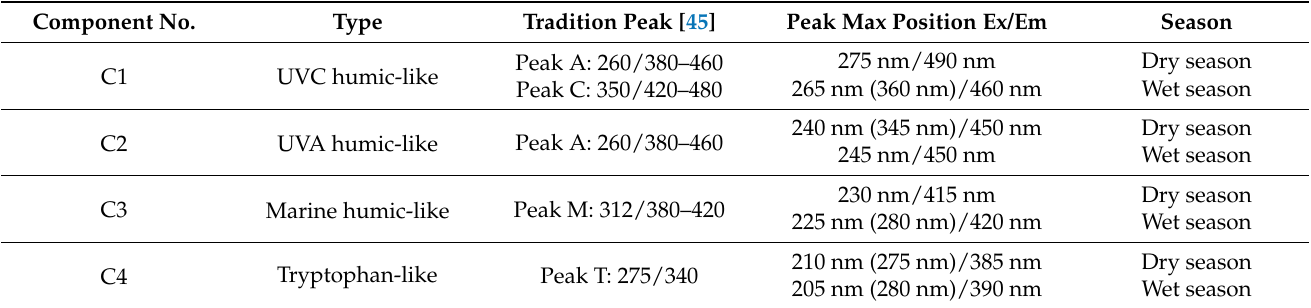
Figure 4. Spectral characteristics of four PARAFAC components during the wet season. Two lines in the excitation and emission (right panels) show the results of split-half validation. Table 1. Spectral characteristics of excitation and emission maxima of four fluorescent components identified by EEM-PARAFAC.